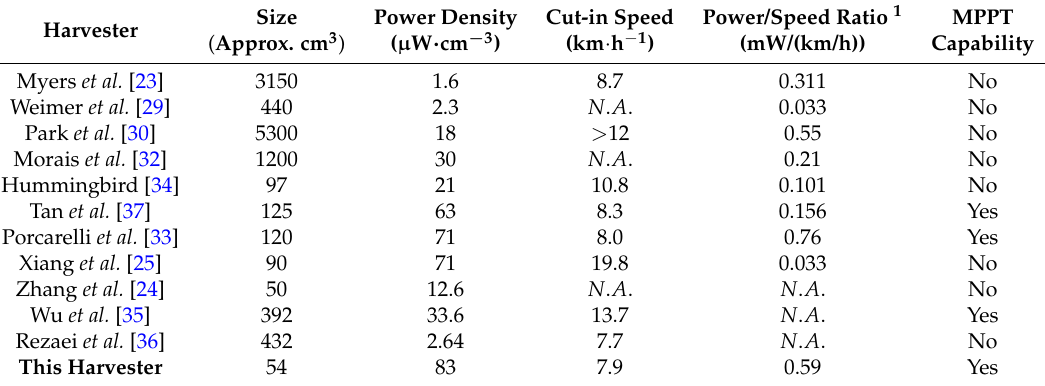
Table 1. Comparison of the characteristics of the wind energy harvester presented the